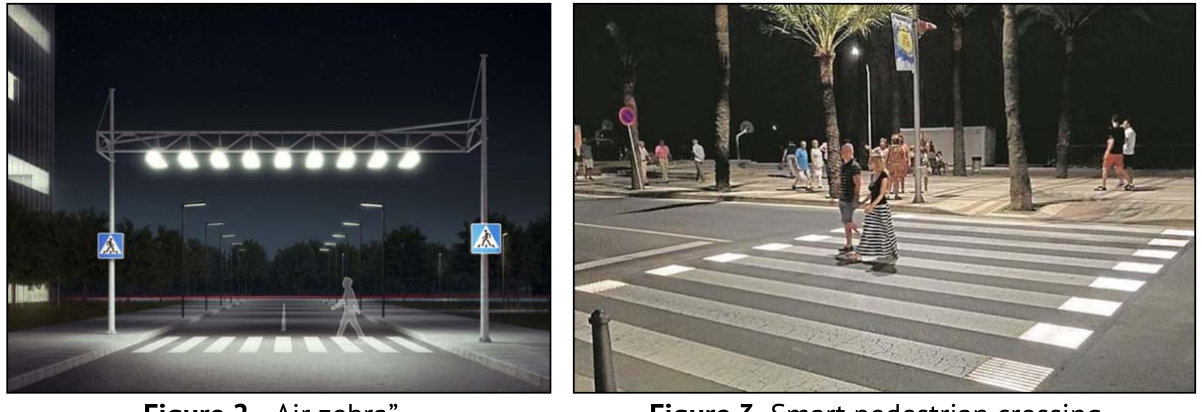
Figure 2. „Air zebra”. Figure 3. Smart pedestrian